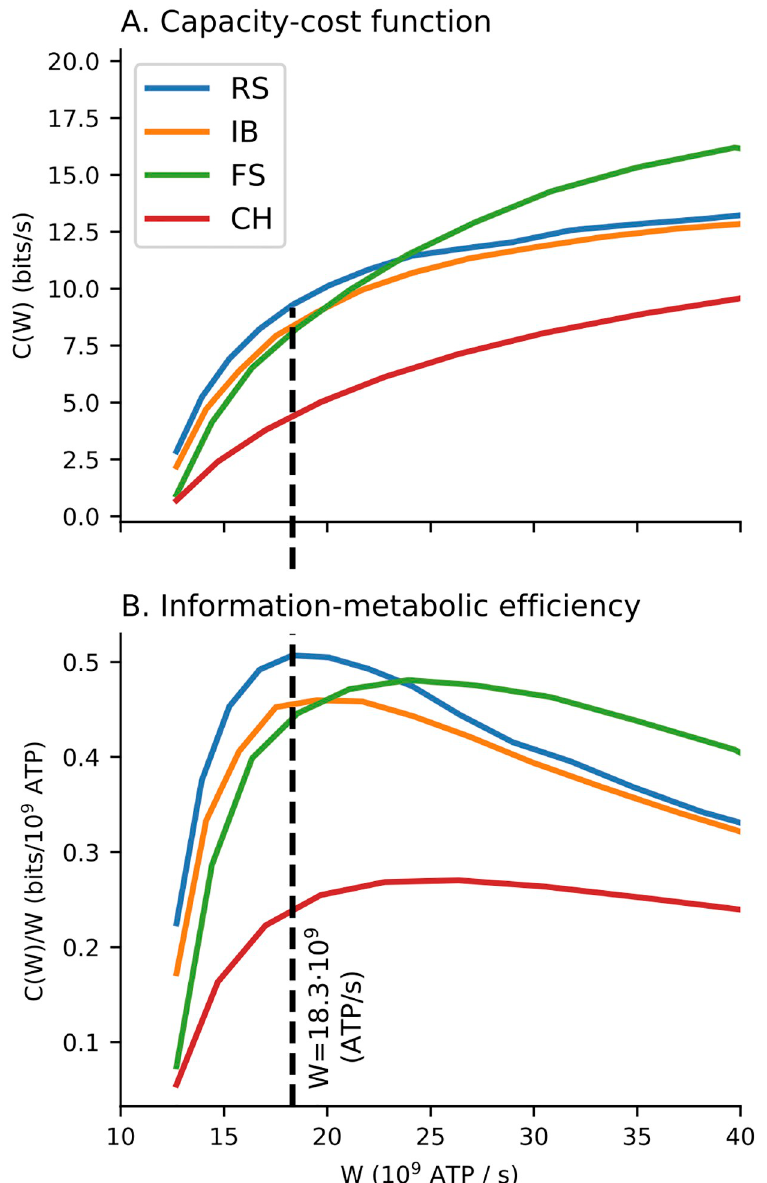
Fig 3. Capacity-cost function. Capacity-cost function (panel A) and capacity per spike (panel B) for the case of coding time window Δ = 100 ms and inhibition scaling factor B = 0.4. The dashed vertical line indicates the cost at which the optimal capacity per spike for the RS neuron is